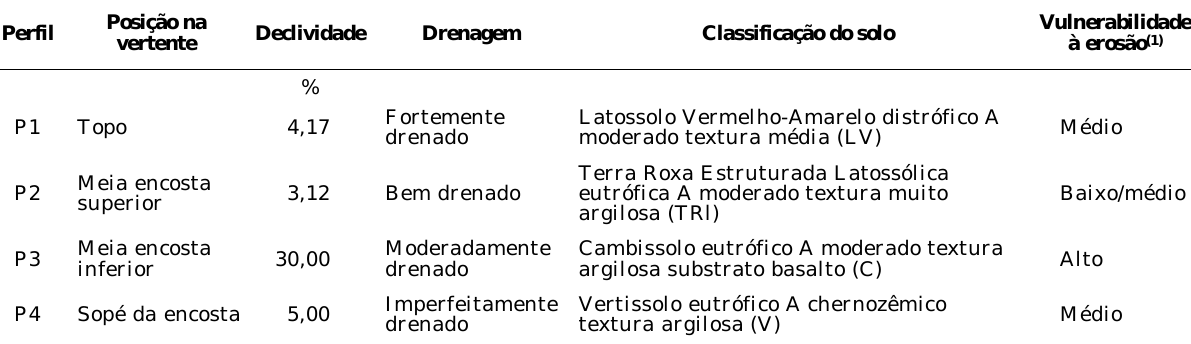
figura 1. Utilizou-se, como padrão de referência absoluta, uma placa com 100% de reflectância. A razão entre o fluxo radiante espectral refletido pela super- fície de uma amostra e o fluxo radiante espectral